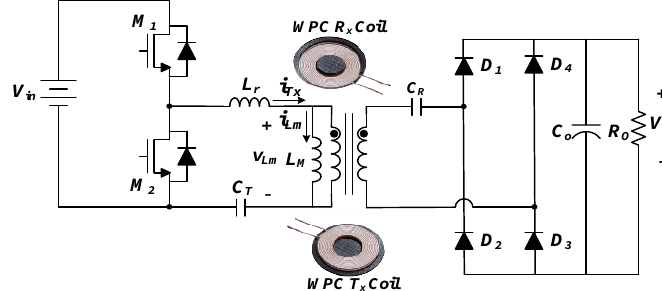
Figure 6. Equivalent LLC resonant resonance circuit in the over coupling condition.